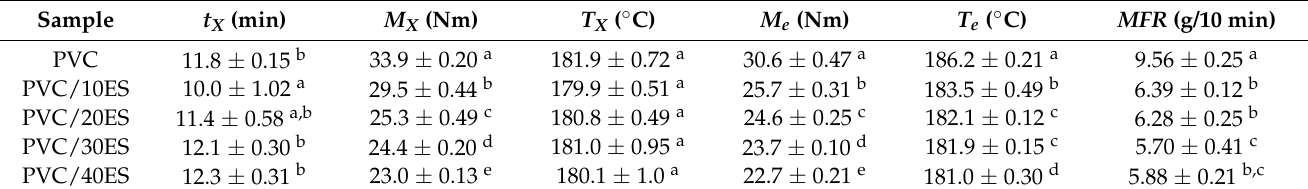
Figure 4. An Exemplary plastogram of PVC and PVC/40ES processing. Table 1. Values of plastografometric and MFR analysis.